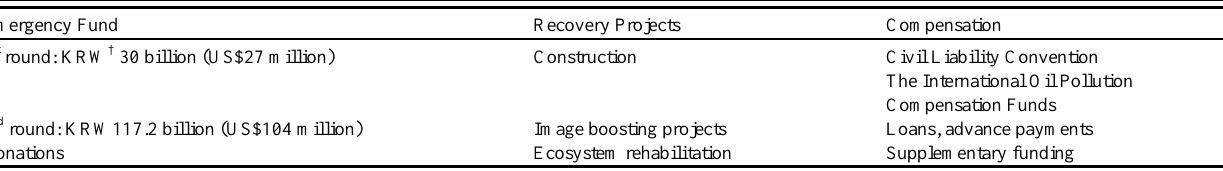
Table 2 . Financial resources from outside the local economy for disaster recovery and local compensation after the Hebei-Spirit oil spill in South Korea.